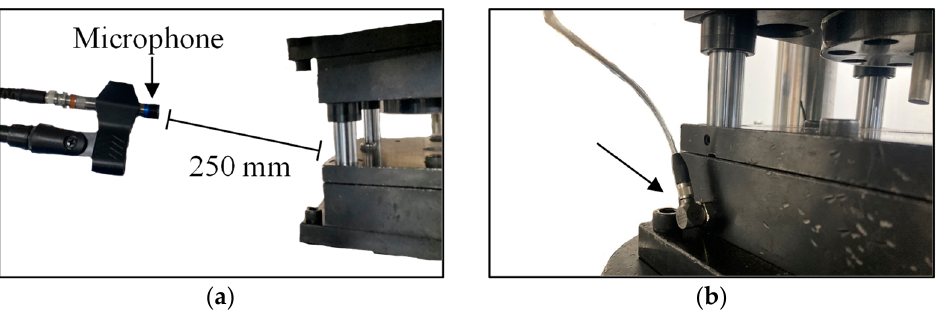
Figure 4. Experimental set-up for punching monitoring: position of ( a ) microphone and ( b ) accelerometer.